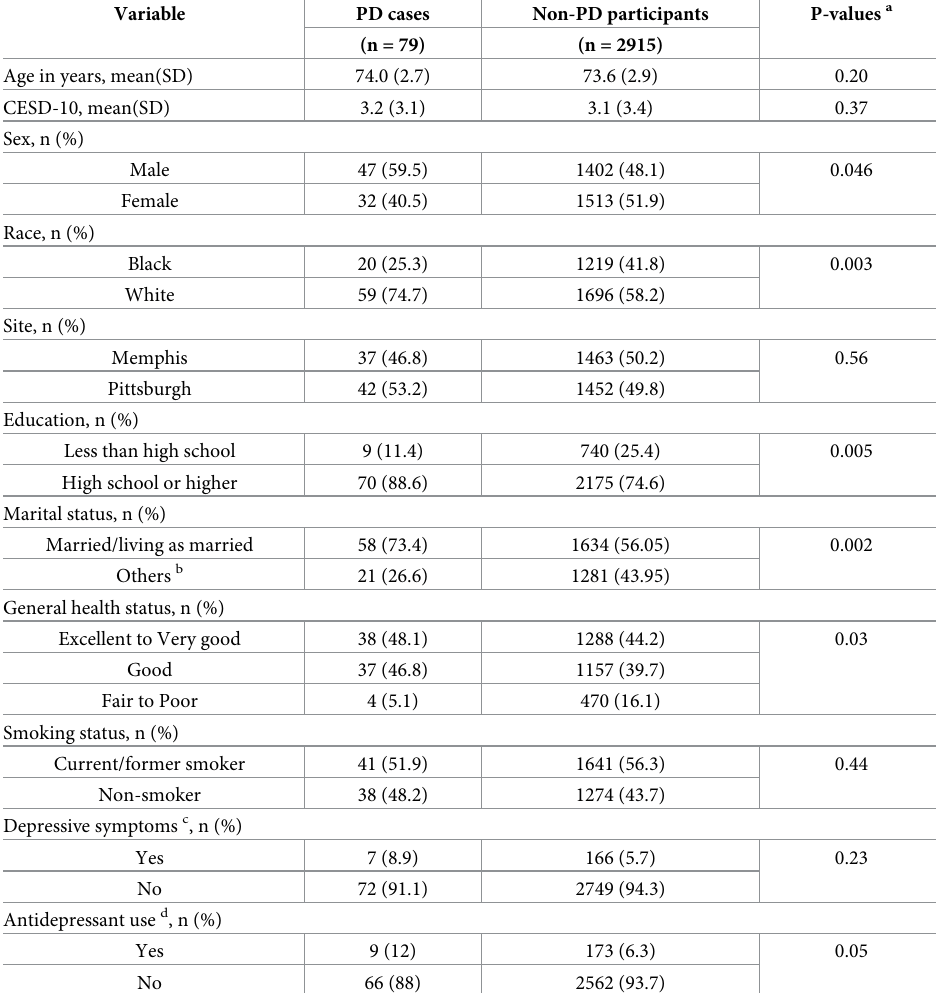
Table 1. Baseline population characteristics of PD cases and non-PD